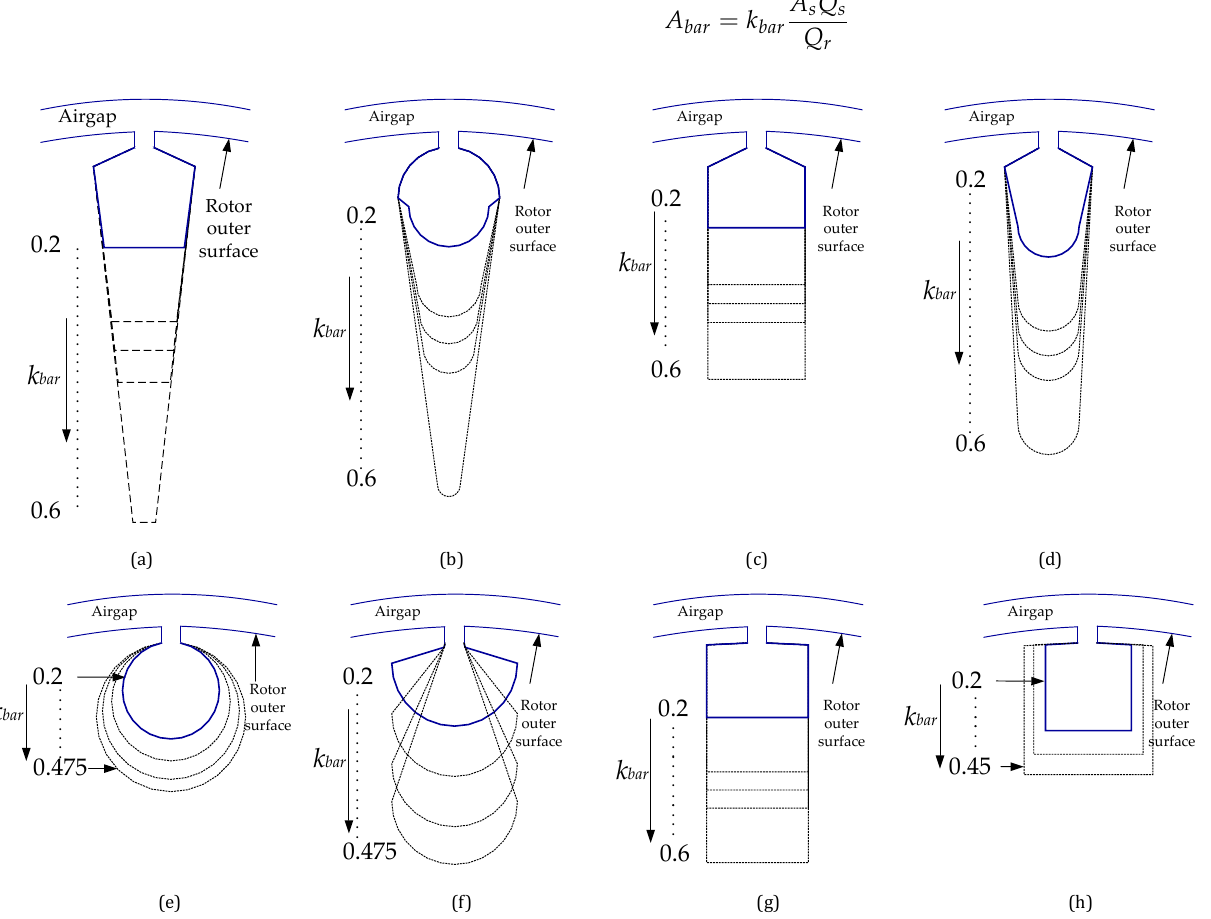
Figure 3. The cross-section variation as a function of k bar for the rotor bar with ( a ) trapezoidal, ( b ) oval, ( c ) pent, ( d ) polygonical, ( e ) round, ( f ) drop, ( g ) rectangular, and ( h ) quadrangular shape. The rotor squirrel-cage structure has the most essential impact (compared to the respective one of other characteristics) on the starting torque of three-phase IMs. This is not valid for the capacitor-run SPIMs, since the effect of the auxiliary winding features (i.e., turns number and run-capacitor value) have to be taken into consideration. The auxiliary winding turns number ( N a ) is obtained from Equation (2) for given main winding turns number ( N m ) and auxiliary to main winding turns ratio ( a ). The N m is estimated through Equation (3), where f is the frequency, 2 p is the poles number, B g is the average airgap magnetic flux density, k dis is the magnetic flux correction factor, E m is the induced voltage of the main winding, and k wm is the fundamental factor of the main winding. The turns ratio influences considerably the SPIM’s magnetomotive force and its overall performance. Its value lies between 1.0 and 2.0 in most cases, but values lower than 1.0 are also permissible, as pointed out in [28]. In [30], the turns ratio is proposed to be set equal to 1.5 as a starting point at the design process. Its final value has to enable the motor to deliver